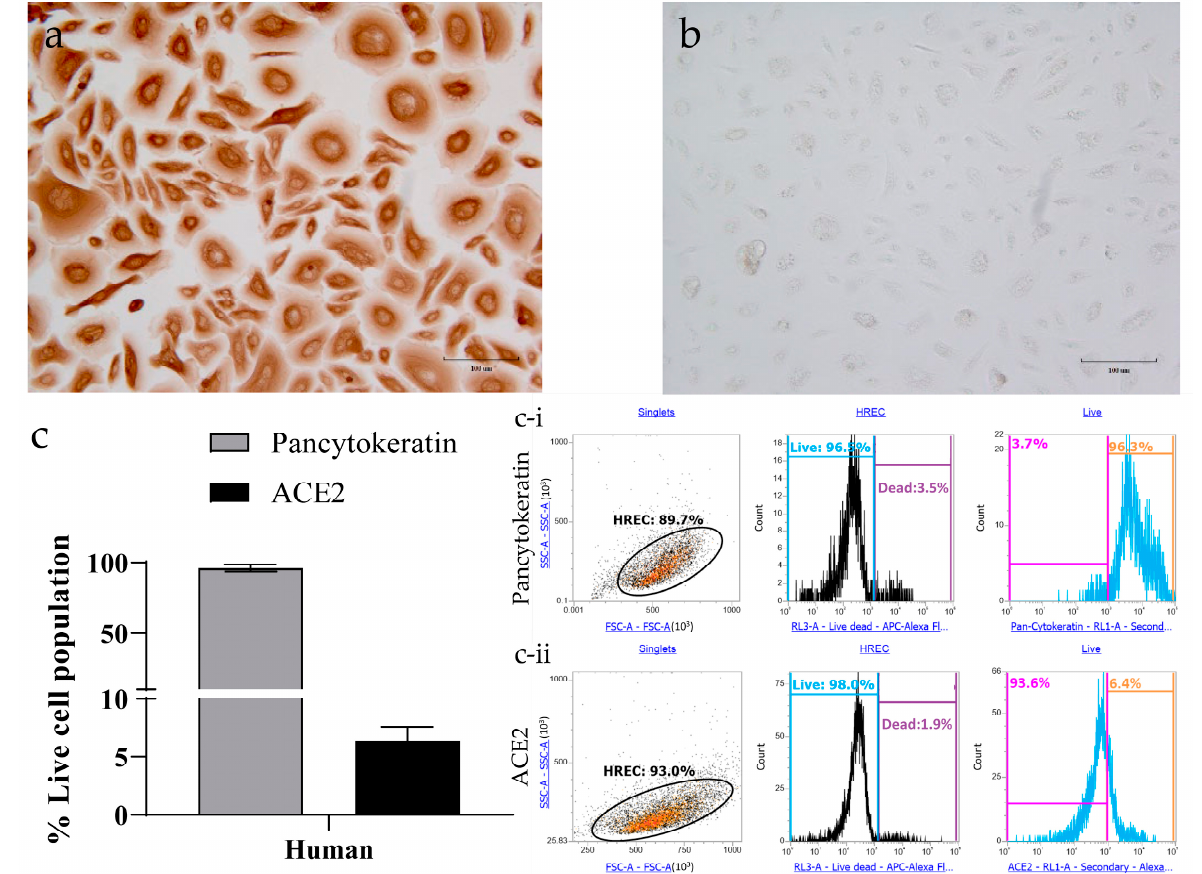
Figure 2. Characterization of human respiratory epithelial cells (HRECs) for pan-cytokeratin and angiotensin-converting enzyme-2 (ACE2) using target-specific markers. Primary HRECs stained for mouse monoclonal to anti-pan-cytokeratin (epithelial cell marker; 0.5 µ g/mL) showed strong expression both in ( a ) IHC and ( c ) flow cytometry analysis. ( b ) HRECs incubated with a secondary antibody only displayed minimum background. ( c ) HRECs were also quantified for the ACE2 expression using flow cytometry. Flow cytometry data was collected using an Attune NxT flow cytometer. A representative of 10,000 events were acquired and analyzed for each sample. Cells were gated for singlet population using forward (FSA) and side-scatter (SSA) properties, and the mean of percent live cell population was used to quantify the levels of ( c-i ) pan-cytokeratin and ( c-ii ) ACE2 ( n = 4). The bar graph represents the mean with the standard error of the mean (SEM). 3.3. Demonstration of SARS-CoV-2 and HCoV-NL63 Virus Infection in HRECs by IHC SARS-CoV-2 virus stocks were generated in Vero-E6 cells, and the SARS-CoV-2 viral nucleoprotein (positive brown staining) was demonstrated in infected cells 72 h post- inoculation (hpi) via IHC staining (Figure 3a). The virus inoculated HRECs with a multi- plicity of infection (MOI)-2 (Figure 3b) and -1 were susceptible to SARS-CoV-2 infection, and the virus appeared to replicate efficiently in these cells. Similarly, HCoV-NL63 repli- cated in LLC-MK2 cells, and corresponding viral nucleoprotein can be observed at 120 hpi (Figure 3c). Again, the HCoV-NL63 virus could infect and replicate efficiently in HRECs at an MOI-2 (Figure 3d) and -1. As expected, the corresponding mock-inoculated controls (Figure 3e–h) remained negative throughout the infection medium